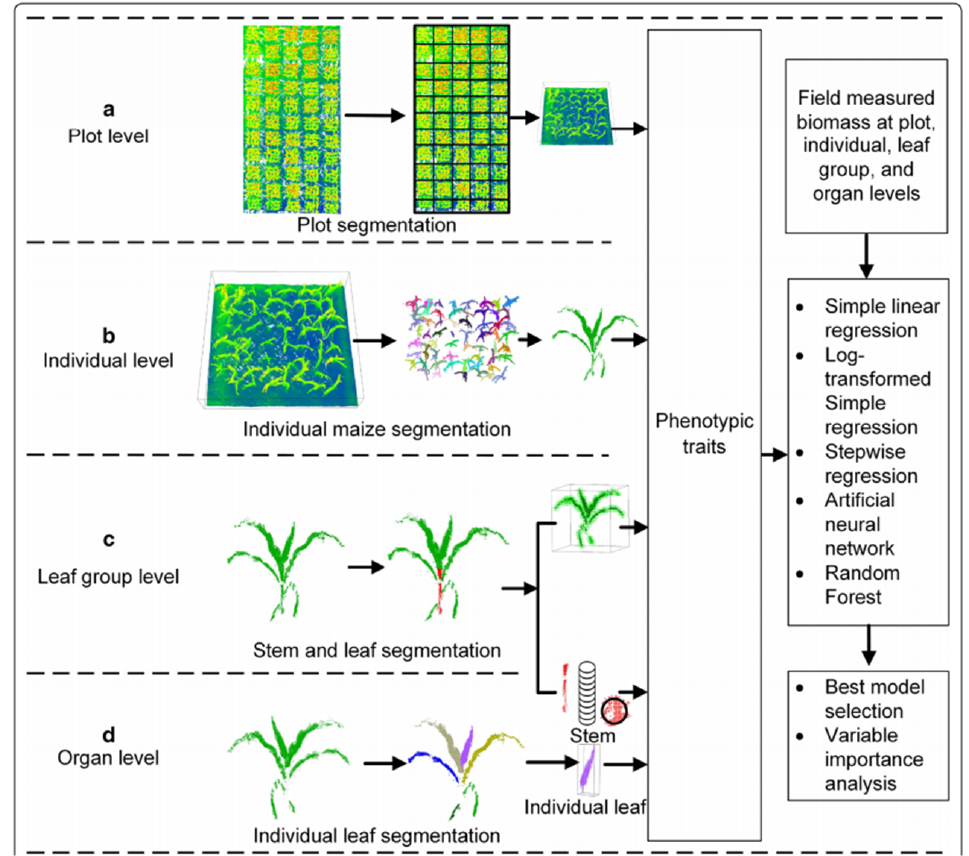
Figure 4 . Workflow of the biomass estimation and best model and phenotypic trait selection at ( a ) plot level, ( b ) individual segmentation, ( c ) stem–leaf segmentation and ( d ) individual leaf segmentation. Reprint from Ref. [14].